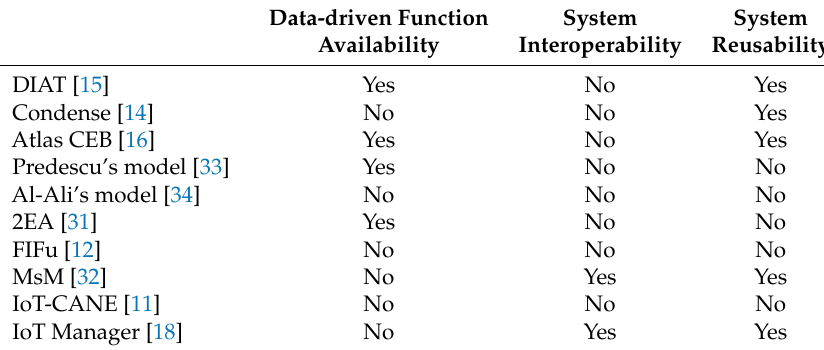
Table 1. Comparisons of different IoT architectures.